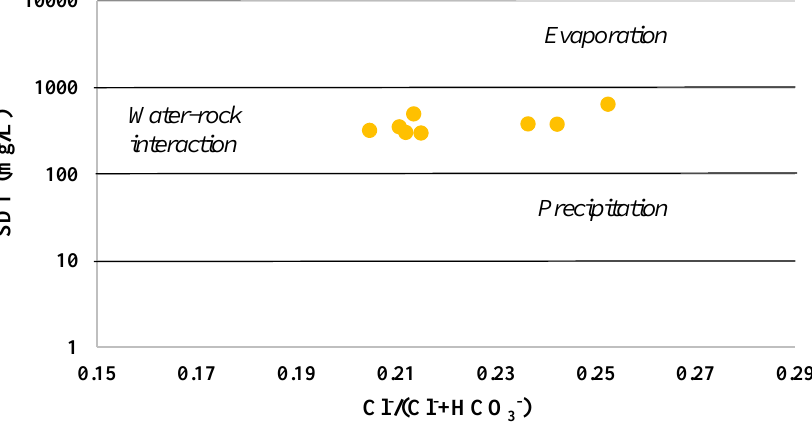
Figure 9. Gibbs diagram of the studied sites related to major anions.